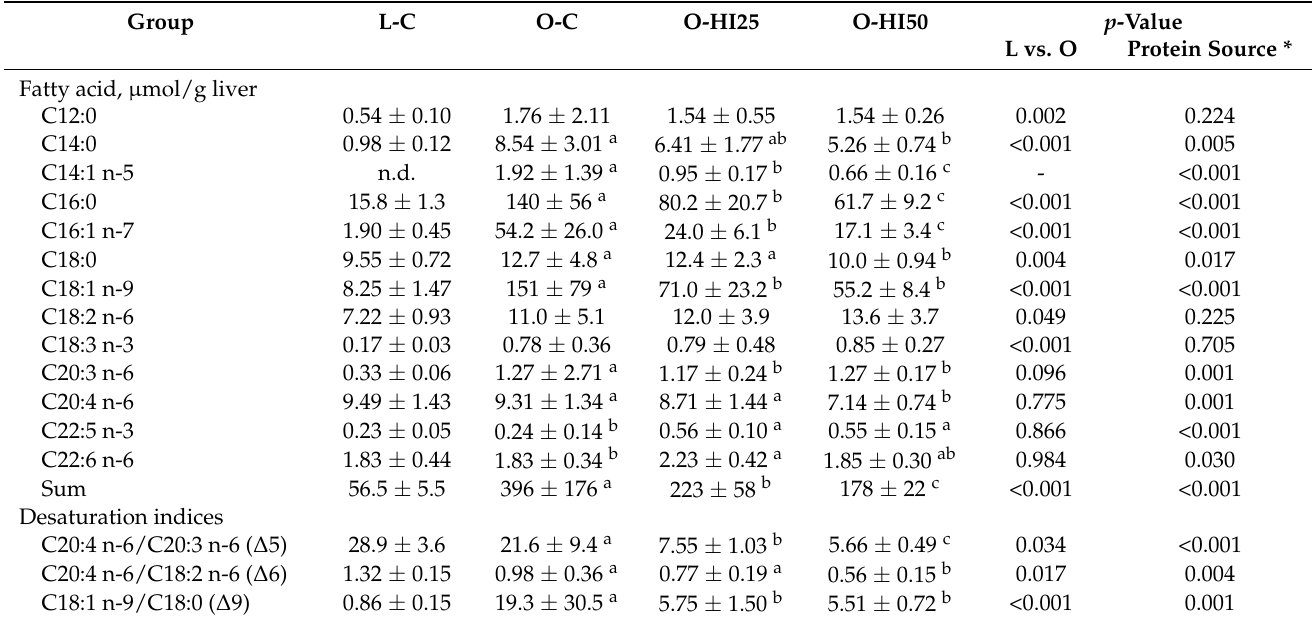
Data are means ± SD for n = 10 rats/group. * Effect of the protein source (C vs. HI25 vs. HI50) within the obese groups: a,b,c Bars without a common letter differ across the obese groups, p < 0.05. n.d., not